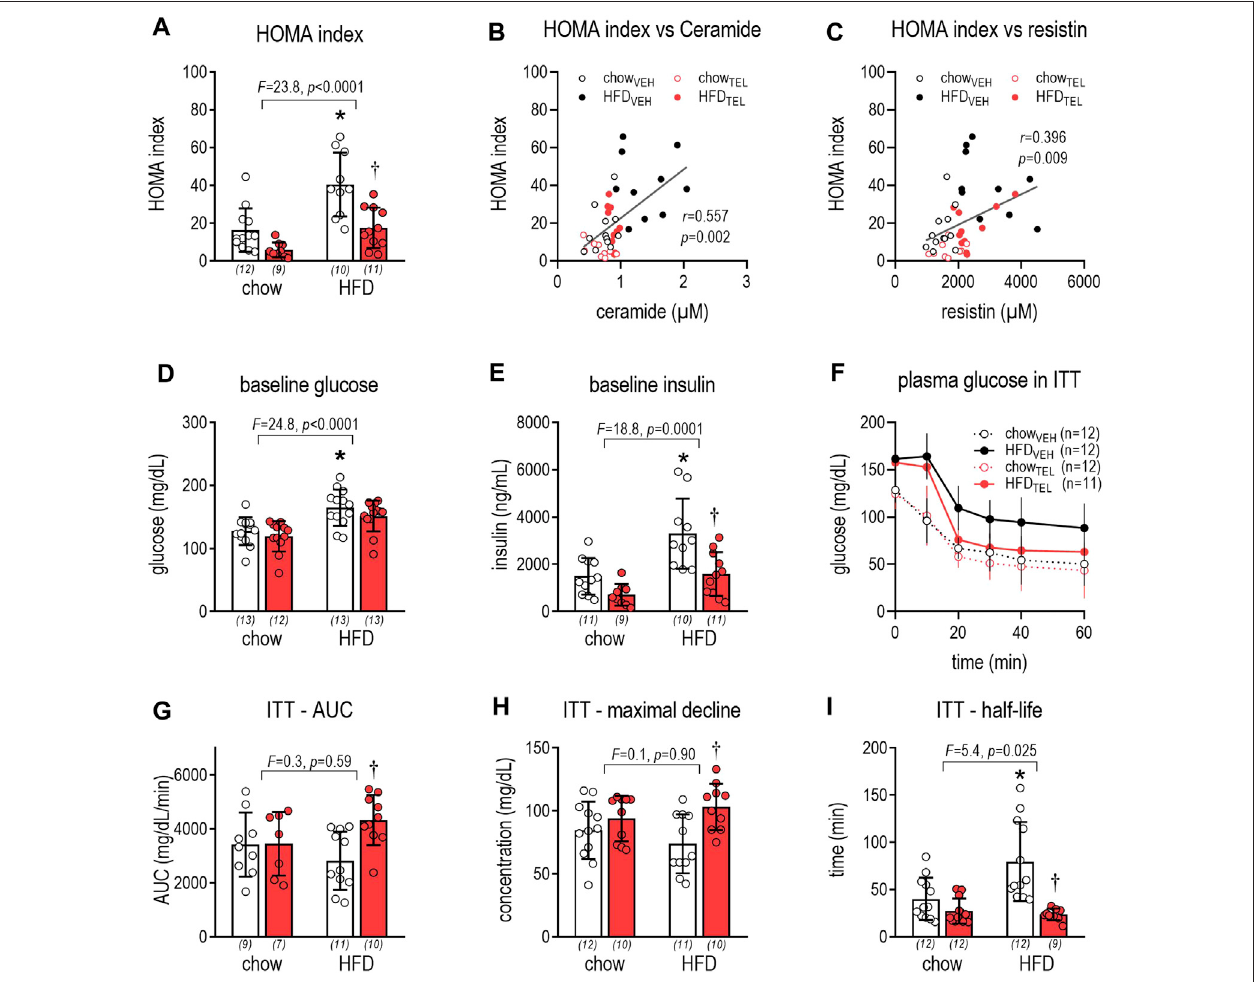
FIGURE2| Glucosecontrolofmicethatwerefedeitherwithchoworhighfatdiet(HFD).MiceweretreatedwithTEL( C ,8 mg/kg/dayredbars)orvehicletreatment openbars(O). (A) HOMAindexafter12 weeksoftreatment(two-wayANOVA;TEL: F =20.1, p < 0.0001,interaction; F =2.9, p =0.097); (B) correlationbetweenHOMA index and plasma ceramide (Pearson; r = 0.557, p = 0.0002); (C) correlation between HOMA index and plasma resistin (Pearson; r = 0.395, p = 0.0095); (D) baseline glucoseafter12 weeksoftreatment(two-wayANOVA;TEL: F =2.4, p =0.127,interaction; F =0.12, p =0.733); (E) baselineinsulinconcentrationafter12 weeksof treatment (two-way ANOVA; TEL: F = 16.3, p = 0.0003, interaction; F = 2.2, p = 0.14); (F) change in plasma glucose in ITT; (G) AUC of plasma glucose levels during ITT (two-wayANOVA;TEL: F =5.2, p =0.028,interaction; F =3.7, p =0.062); (H) maximalglucosedeclineduringITT(two-wayANOVA;TEL: F =9.1, p =0.004,interaction; F = 2.4, p = 0.127); (I) half-life of glucose decline after insulin exposure (two-way ANOVA; TEL: F = 19.9, p < 0.0001, interaction; F = 7.9, p = 0.008). Means ± SD, the individual group size is indicated below the bars in brackets.* p < 0.05 vs. chow VEH , † p < 0.05 vs. HFD VEH .